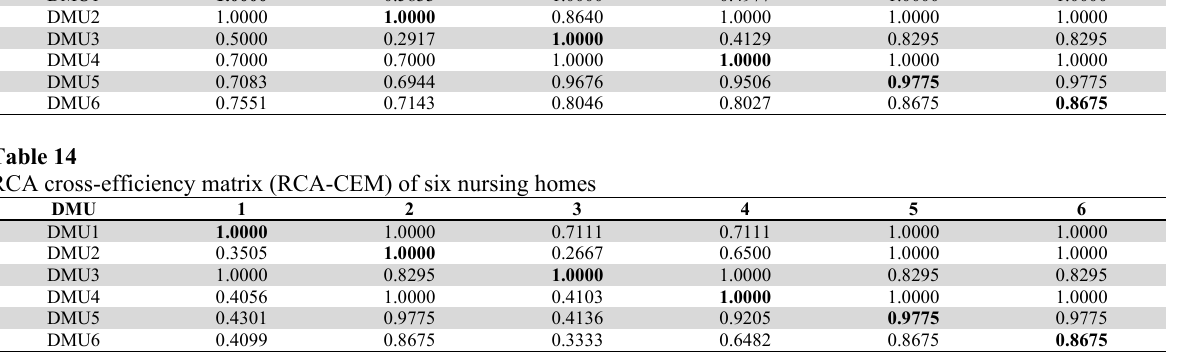
RCB cross-efficiency matrix (RCB-CEM) of six nursing homes DMU 1